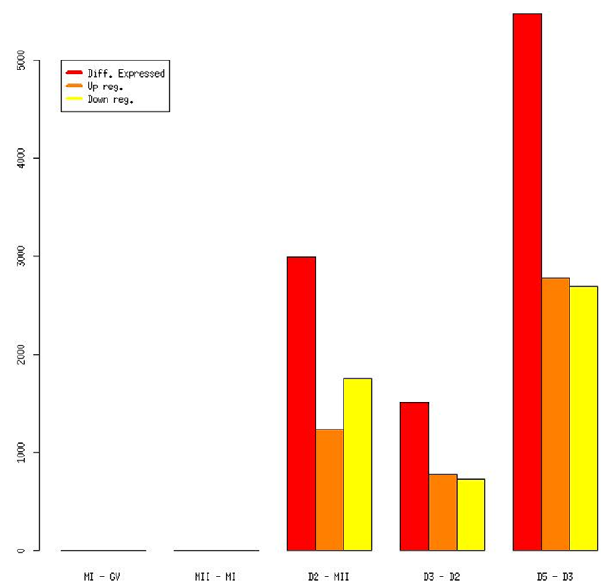
Figure 1. Differentially expressed probe sets between consec- utive developmental stages.